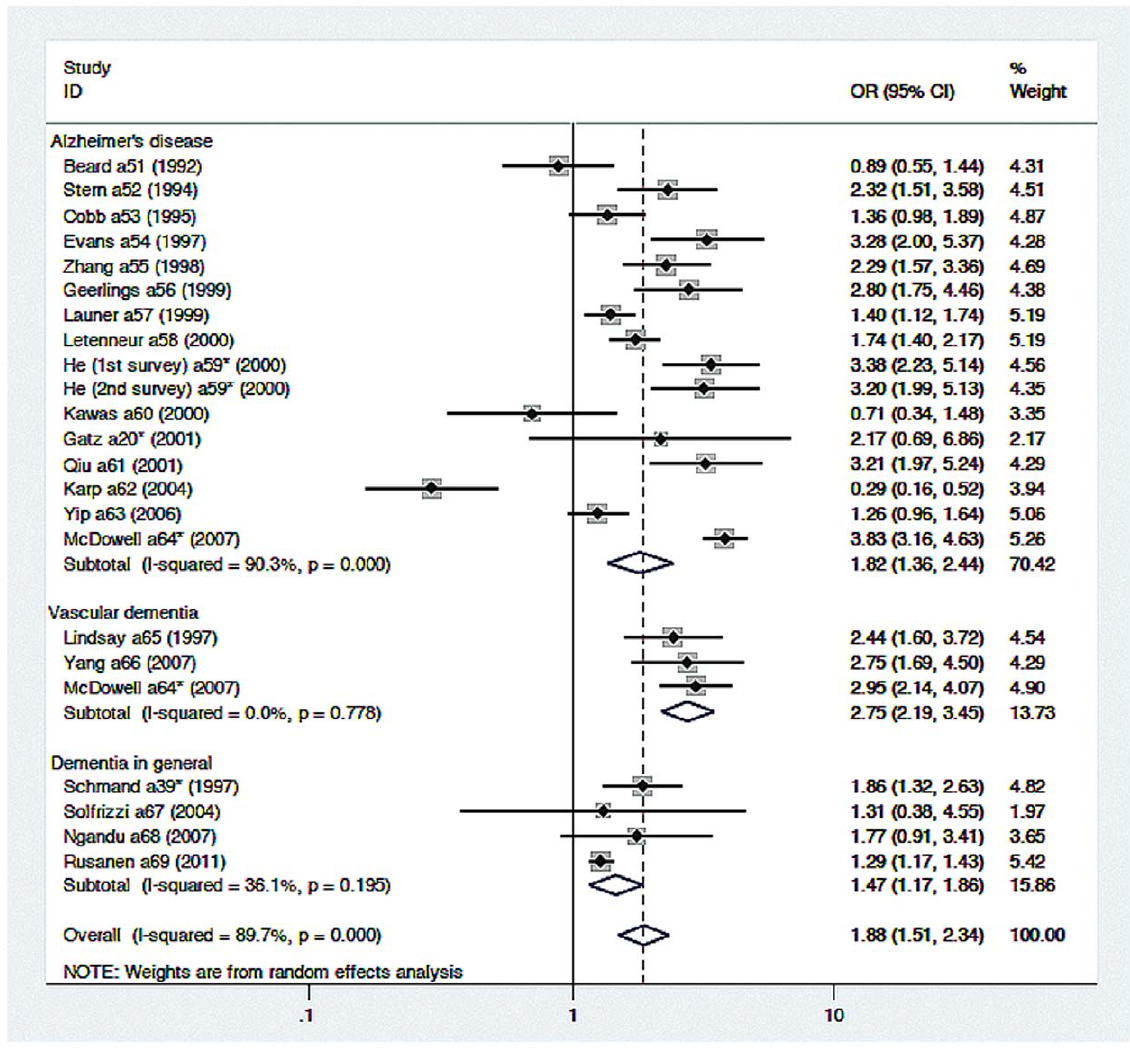
Figure 3. Summary of findings from observational studies of education and the incidence of dementia (* denotes studies with two or more empirical